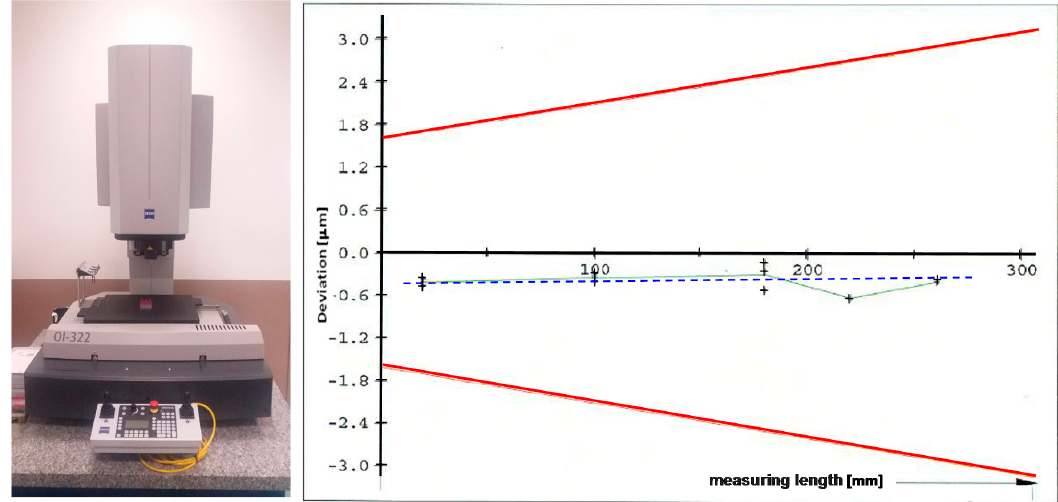
Figure 2. First-order linear trend by axis of a verification test by ISO 10360 (X-axis). CMM model O-Inspect 322 by Carl Zeiss Industrielle Messtechnik GmbH, Oberkochen, Germany, measurement field XxYxZ of 300 mm × 200 mm × 200 mm, including probe head VAST XXT(LT1), and measurement software CALYPSO 2014. Red lines are the control limits at 95% confidence level that establish the maximum permissible